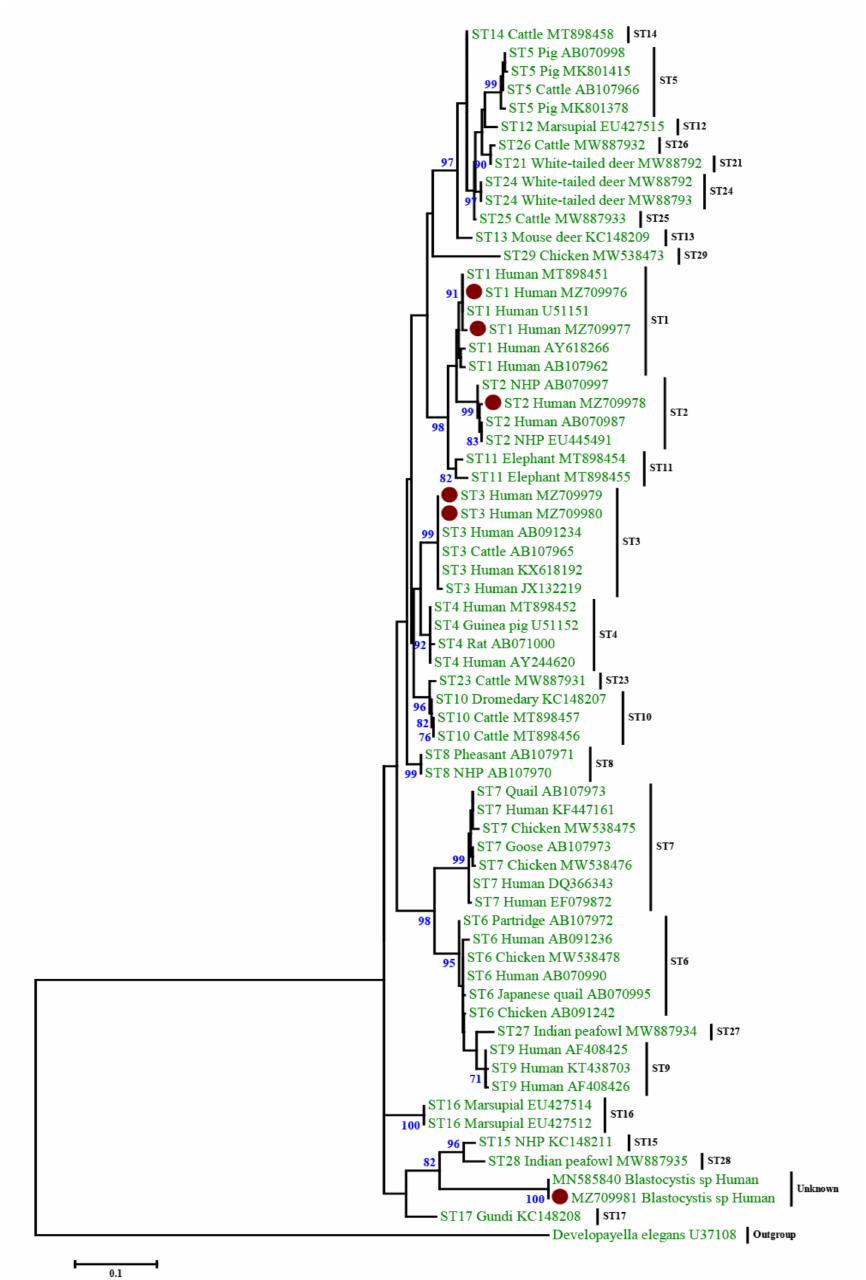
Figure 1. Phylogenetic analysis of Blastocystis using maximum likelihood method based on the SSU rRNA gene sequences. Developayella elegans was used as outgroup taxon to root the tree. Analysis was conducted by a maximum likelihood method. Genetic distances were calculated using the Kimura two-parameter model. This analysis involved 66 nucleotide sequences. Bootstrap values lower than 60% are not displayed. The Blastocystis sequences determined in this study are indicated with a red